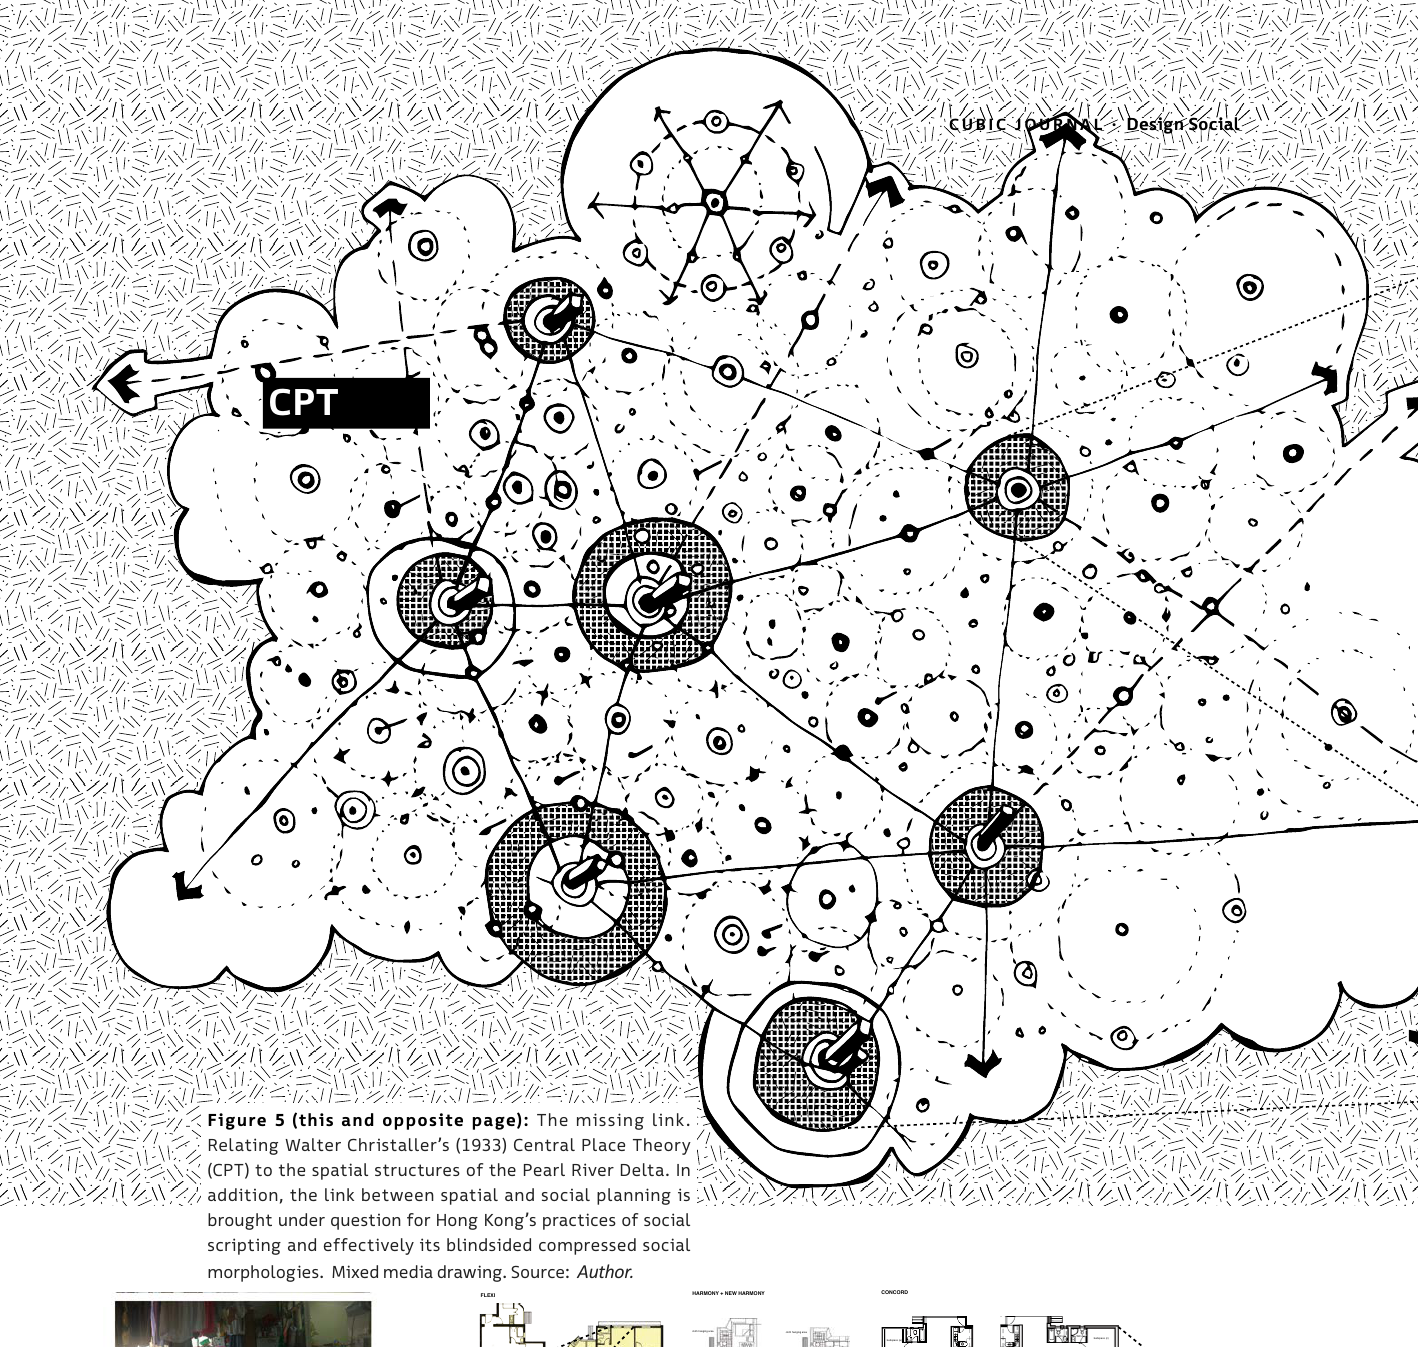
Figure 5 (this and opposite page): The missing link. Relating Walter Christaller’s (1933) Central Place Theory (CPT) to the spatial structures of the Pearl River Delta. In addition, the link between spatial and social planning is brought under question for Hong Kong’s practices of social scripting and effectively its blindsided compressed